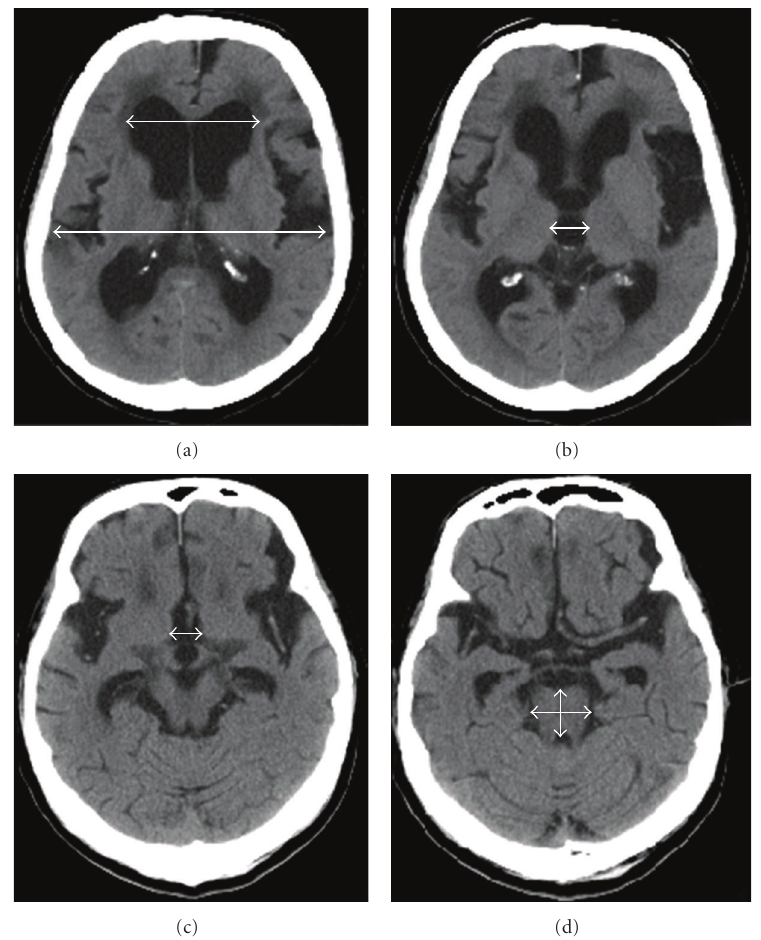
Figure 1: Measurements for iNPH patients on CT scans. (a) Evans index (ratio of maximum width of the frontal horns to the maximum width of the inner table of the cranium); (b) maximum width of the third ventricle at the foramen of Monro (interventricular foramen); (c) maximum width of the third ventricle at the superior colliculus; (d) anteroposterior (vertical) and left-to-right (horizontal) diameters of the midbrain at pontomesencephalic